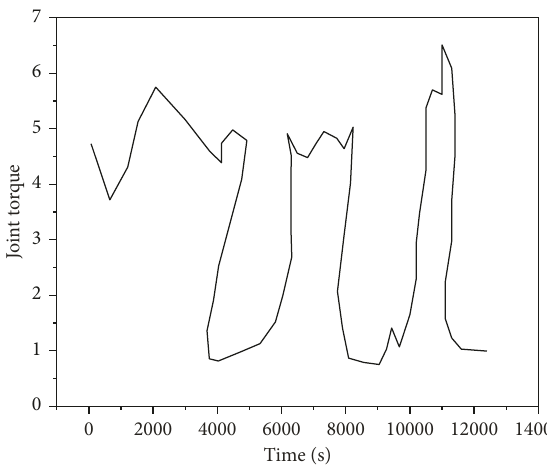
Figure 7: Collision experimental results of inspection robot in experimental test.